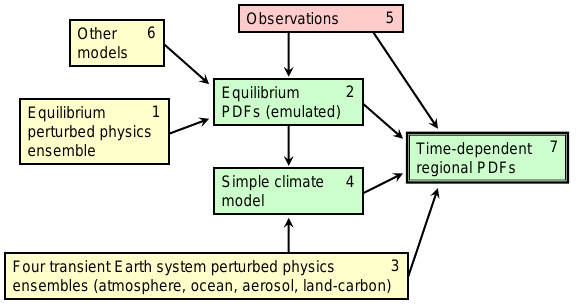
Fig. 1. Flowchart showing the links between the seven components of the methodology described in more detail in Sect. 3 for the pro- duction of probabilistic predictions of future climate change. Boxes in red denote observational data, boxes in yellow represent ensem- bles of GCM simulations, and boxes in green represent statistical and other techniques required to convert the simulations into prob- abilistic